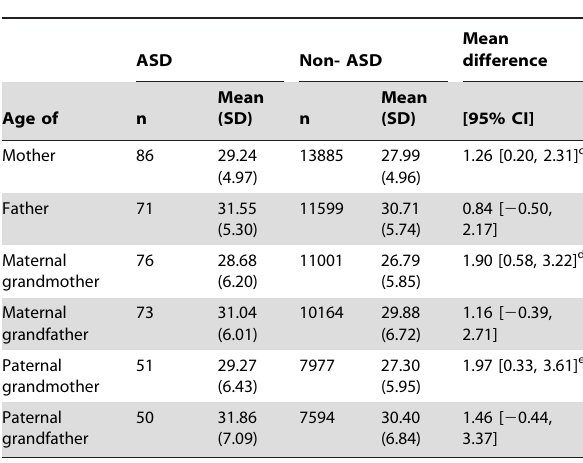
Table 1. Comparison of mean ages of parents a and grandparents b of children with and without ASD.